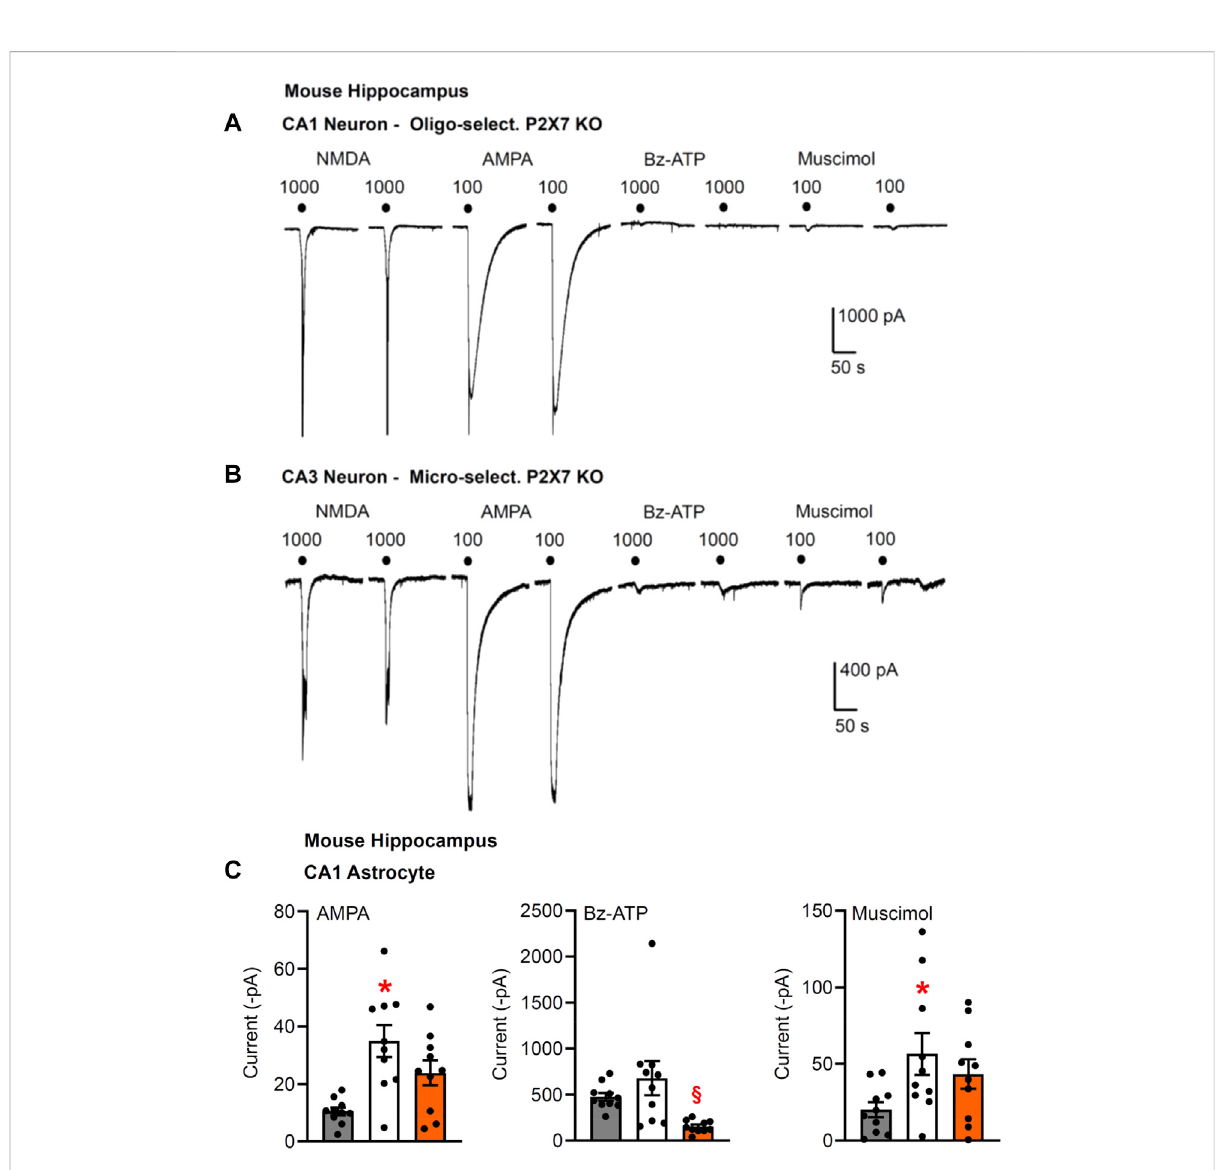
FIGURE 3 Current responses to ionotropic receptor agonists in the CA1 and CA3 areas of the mouse hippocampus. Hippocampal brain slices of 10 – 15 day-old wild-type mice, as well as mice whose P2X7Rs were genetically deleted in all cells, or selectively in oligodendrocytes or microglia. NMDA (100 µM), AMPA (100 µM), Bz-ATP (1,000 µM) and muscimol (100 µM) were locally superfused every 3 min, each agonist twice. The membrane currents were recorded in astrocytes by means of the whole-cell patch-clamp method at a holding potential of − 80 mV, and in neurons at a holding potential of − 70 mV. Representative tracings in neurons (A,B) . (C – E) Mean ± SEM current amplitudes. (C) Effects of AMPA, Bz- ATP, and muscimol in CA1 astrocytes of the three types of animals. * p < 0.05; statistically signi fi cant difference from results in wild-type animals (AMPA, F 2,18 =7.565, p =0.0030;muscimol, F 2,18 =3.553, p < 0.0427;two-wayANOVAfollowedbytheTukey ’ stest). (D,E) SimilarexperimentsasinC, but instead of astrocytes, CA1 or CA3 pyramidal neurons were used for the investigations. Mean ± SEM current amplitudes. * p < 0.05; statistically signi fi cant difference from results in wild-type mice (Bz-ATP, F 2,18 = 3.632, p = 0.0432; two-way ANOVA followed by the Tukey ’ s